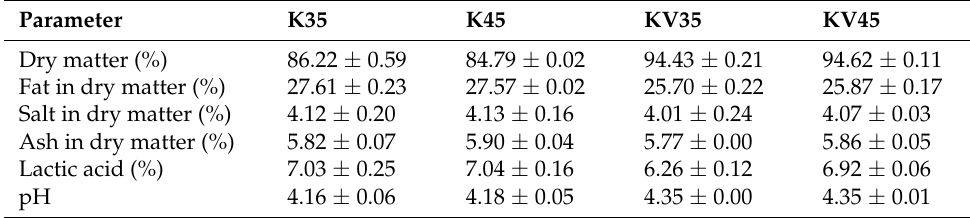
Table 3. Proximate composition of VOD- and OD-applied Kurut samples a . Parameter K35